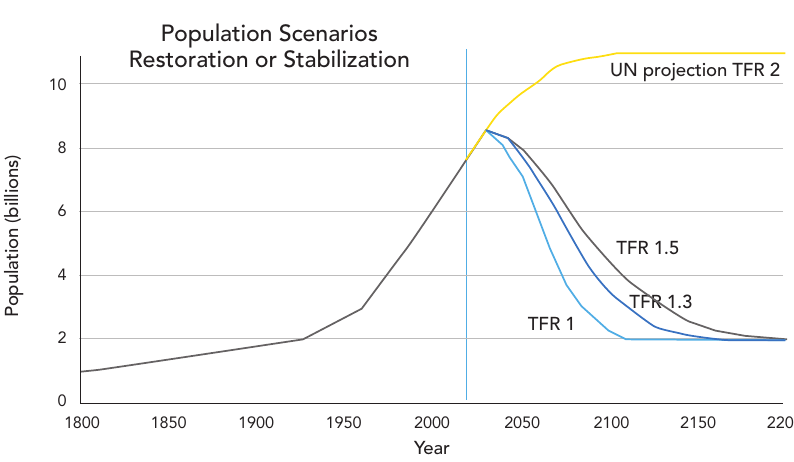
Figure 3. Population Scenarios – Restoration or Stabilisation. Alternative pathways for population growth or degrowth to sustainable levels (average age at first birth = 25, average age at death =